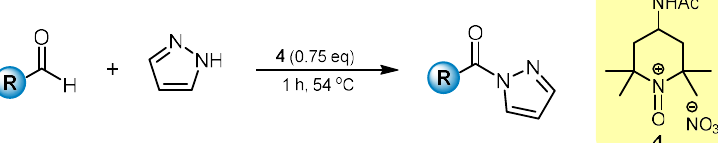
Figure 2. Oxidative amidation of aldehydes with pyrazole to prepare acyl pyrazoles using a substoichiometric quantity of oxoammonium salt 4 .